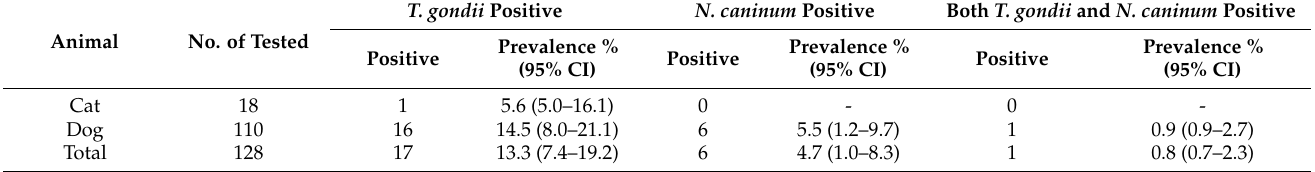
Figure 3. Molecular detection of T. gondii and N. caninum infection in stray cats and dogs in the QTPA using qPCR based on Tg B1 and Nc Nc5. ( A ) The Ct value of qPCR; the critical point was 10 and 30. ( B ) The parasite burdens of T. gondii and N. caninum in 50 ng fecal DNAs using a standard curve prepared by qPCR with two different parasite numbers. Table 2. Molecular infection rates of T. gondii and N. caninum among stray cats and dogs in the QTPA, China.